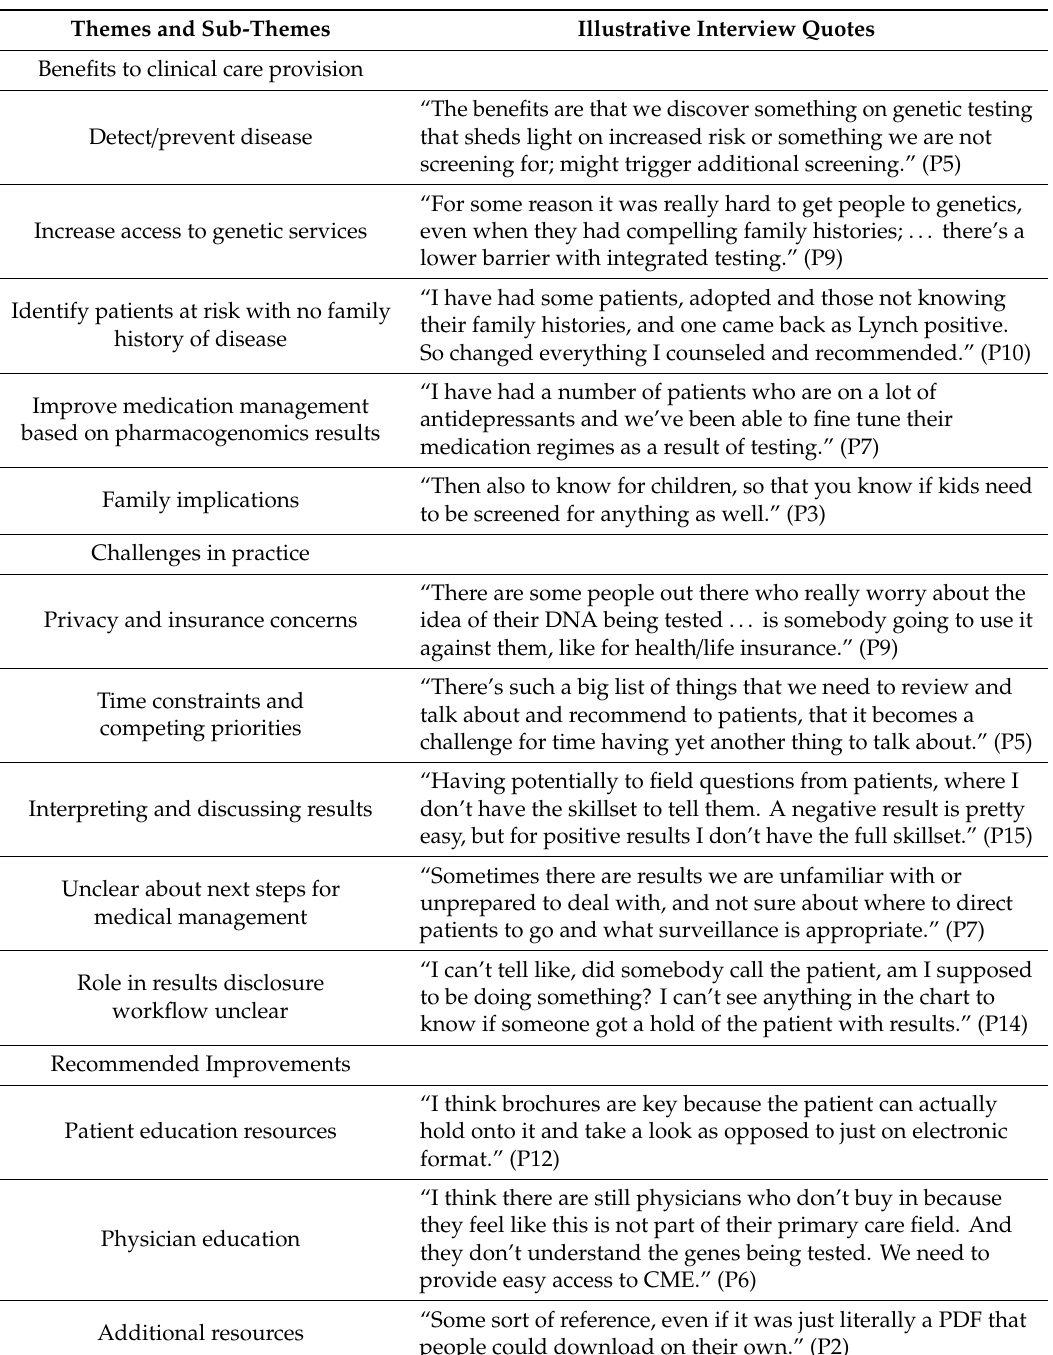
Table 1. Themes and illustrative quotes from primary care physician